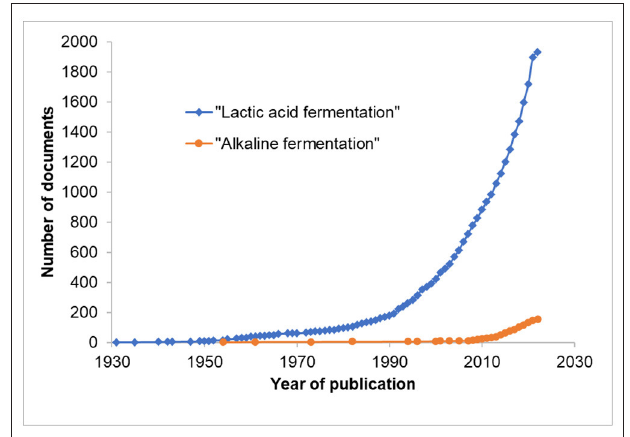
FIGURE 1 | Comparison of cumulative publication outputs in Scopus database on the search terms “lactic acid fermentation” and “alkaline fermentation” (Search done on 23rd February